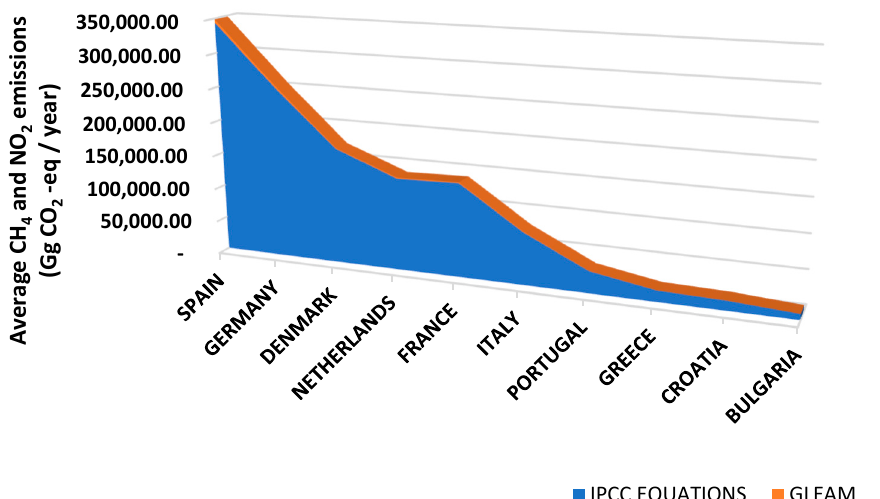
Figure 3. Comparison of mean CH 4 and N 2 O emissions from manure management using Tier 2 IPCC equations) and GLEAM-i software (FAO, Rome, Italy) (Gg CO 2 -eq/year). The different thickness of each graph (blue or red) represents the different estimated emissions by the two methodologies.